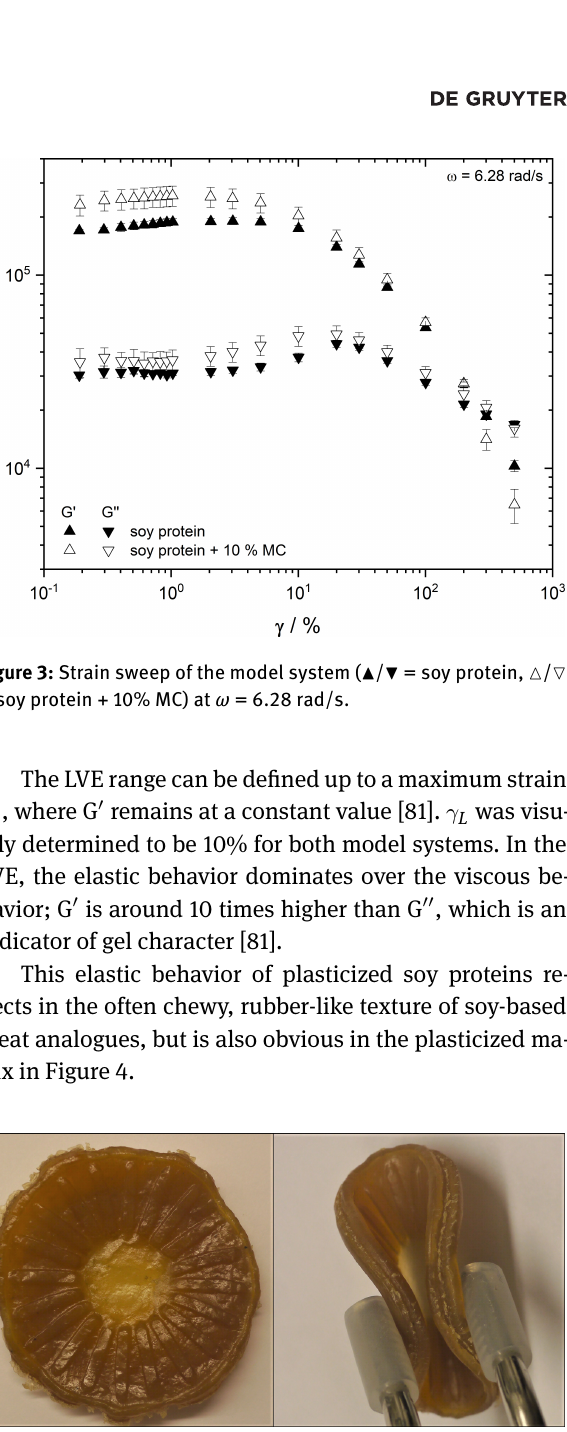
Figure 4: Elasticity of the plasticized soy protein after measurement, visualized by manual deformation. The deformation is completely